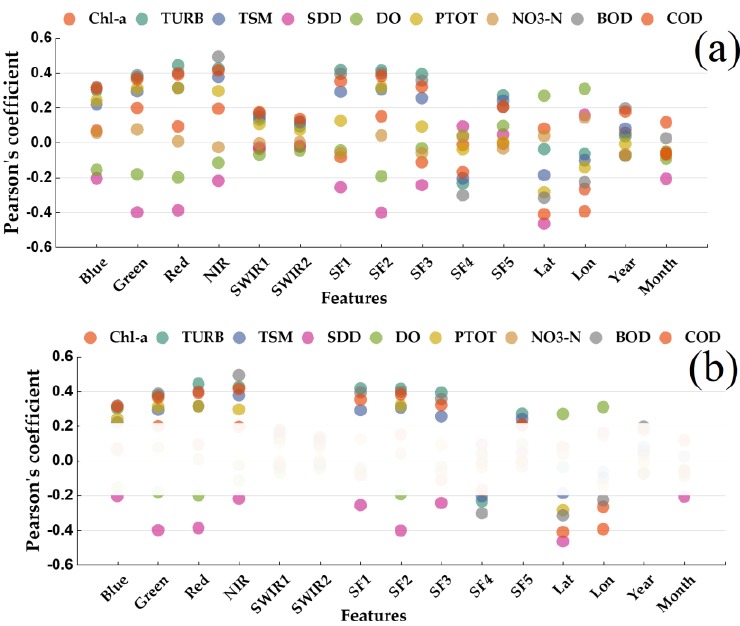
Figure 10. Individual correlation of each predictor with water quality parameters. Features are ranged from − 1 to 1 depending on their higher positive or negative correlation. ( a ) displays correlations of predictors and targets. ( b ) fades the areas of very low or zero correlation ( − 0.20 ≤ r ≤ 0.20).